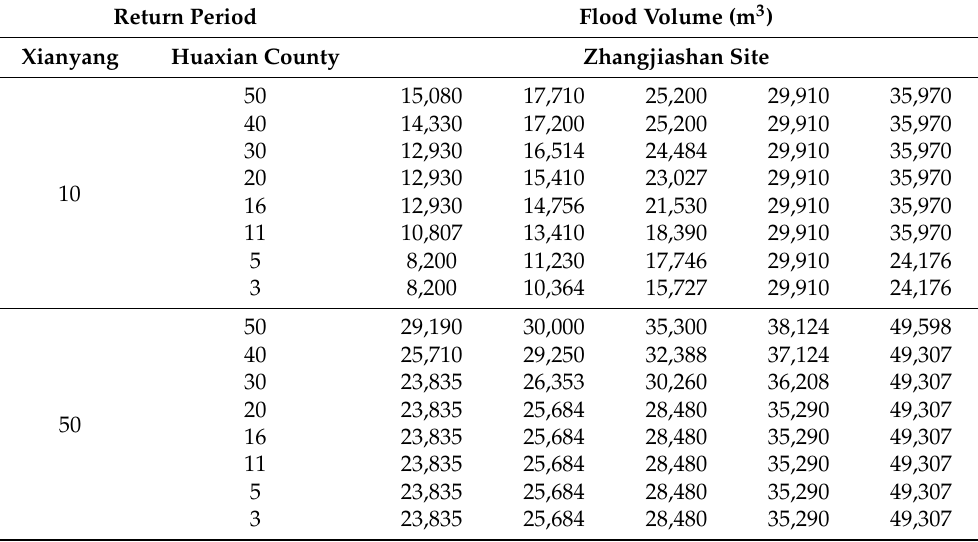
Table 5. Flood volume of Zhangjiashan under different return periods of Xianyang and Huax- ian County.